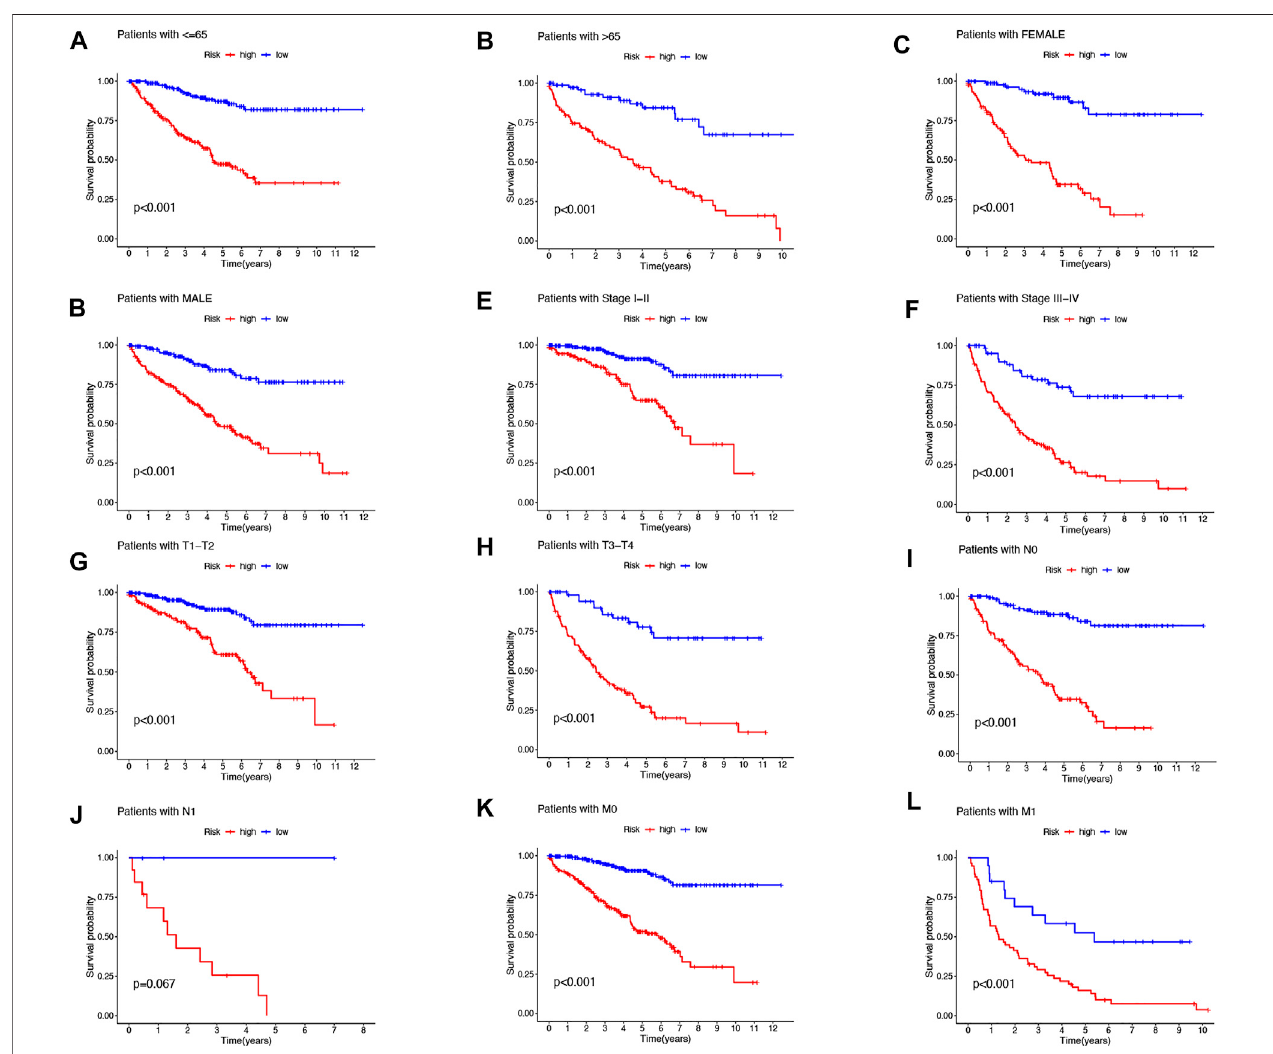
FIGURE3 | Kaplan – Meier survival curves forlow- and high-risk populations by different clinical variables. Age (A , B) , sex (C , D) , stage (E , F) , Tstage (G , H) , Nstage (I , J) , and M stage (K , L) .